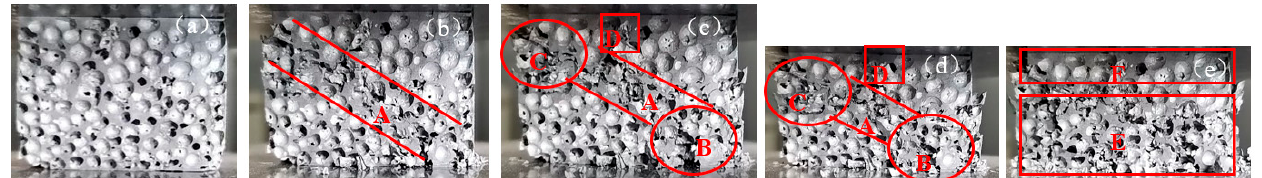
Figure 5. The macroscopic diagram of the deformation process of two-layered gradient Al foams with a cell size of 4-3. Deformation strain: ( a ) ε = 0.01, ( b ) ε = 0.08, ( c ) ε = 0.21, ( d ) ε = 0.38, ( e ) ε = 0.46; A indicates shear deformation, B and C indicate local regional collapse deformation, D indicates the damage extended to other weak areas, E indicates obviously collapsed area, F indicates still intact overall cell shape.